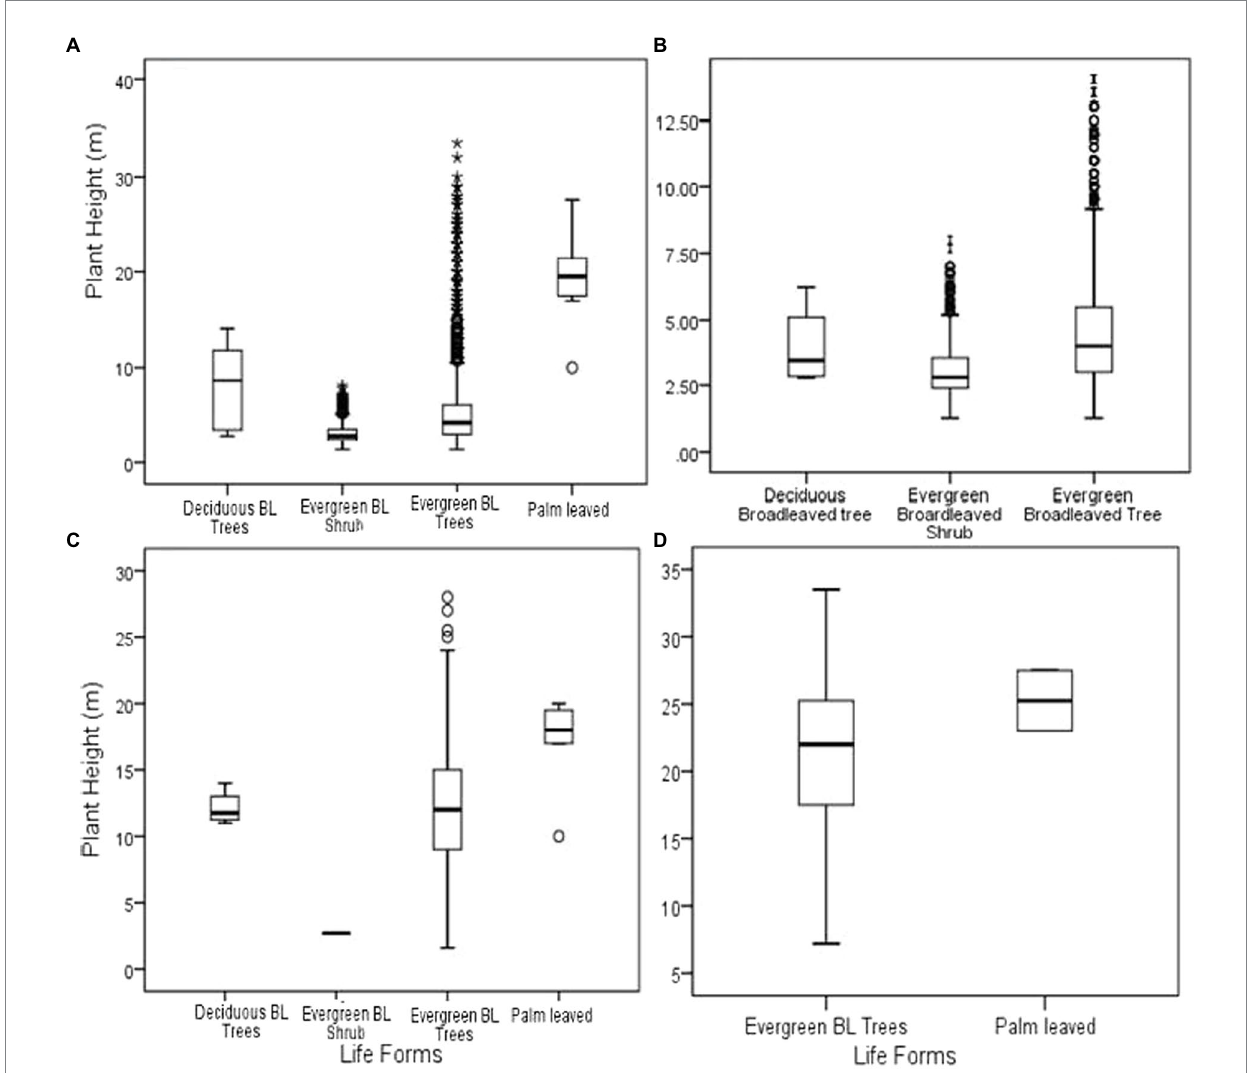
FIGURE 2 Tree height for the entire forest (A) ; less than 10 cm DBH (B) , 10–30 cm DBH (C) , and above 30 cm DBH (D) . *BL (Broad